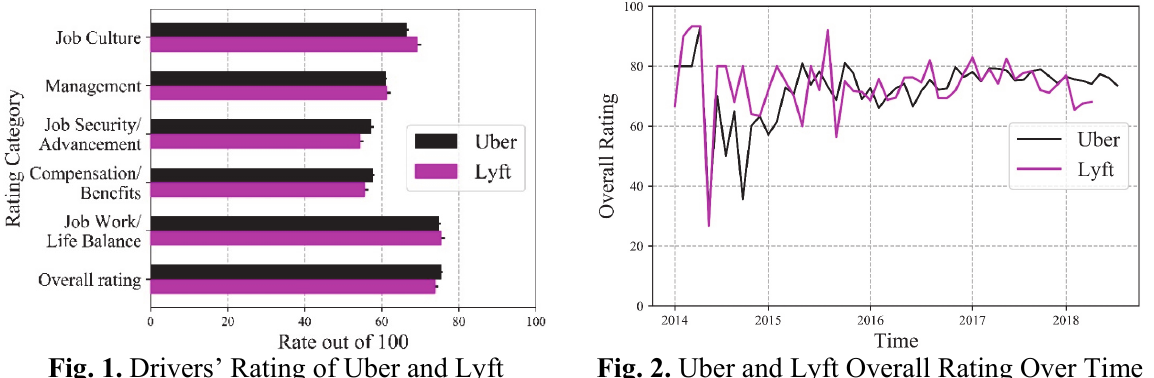
Fig. 1. Drivers’ Rating of Uber and Lyft Fig. 2. Uber and Lyft Overall Rating Over